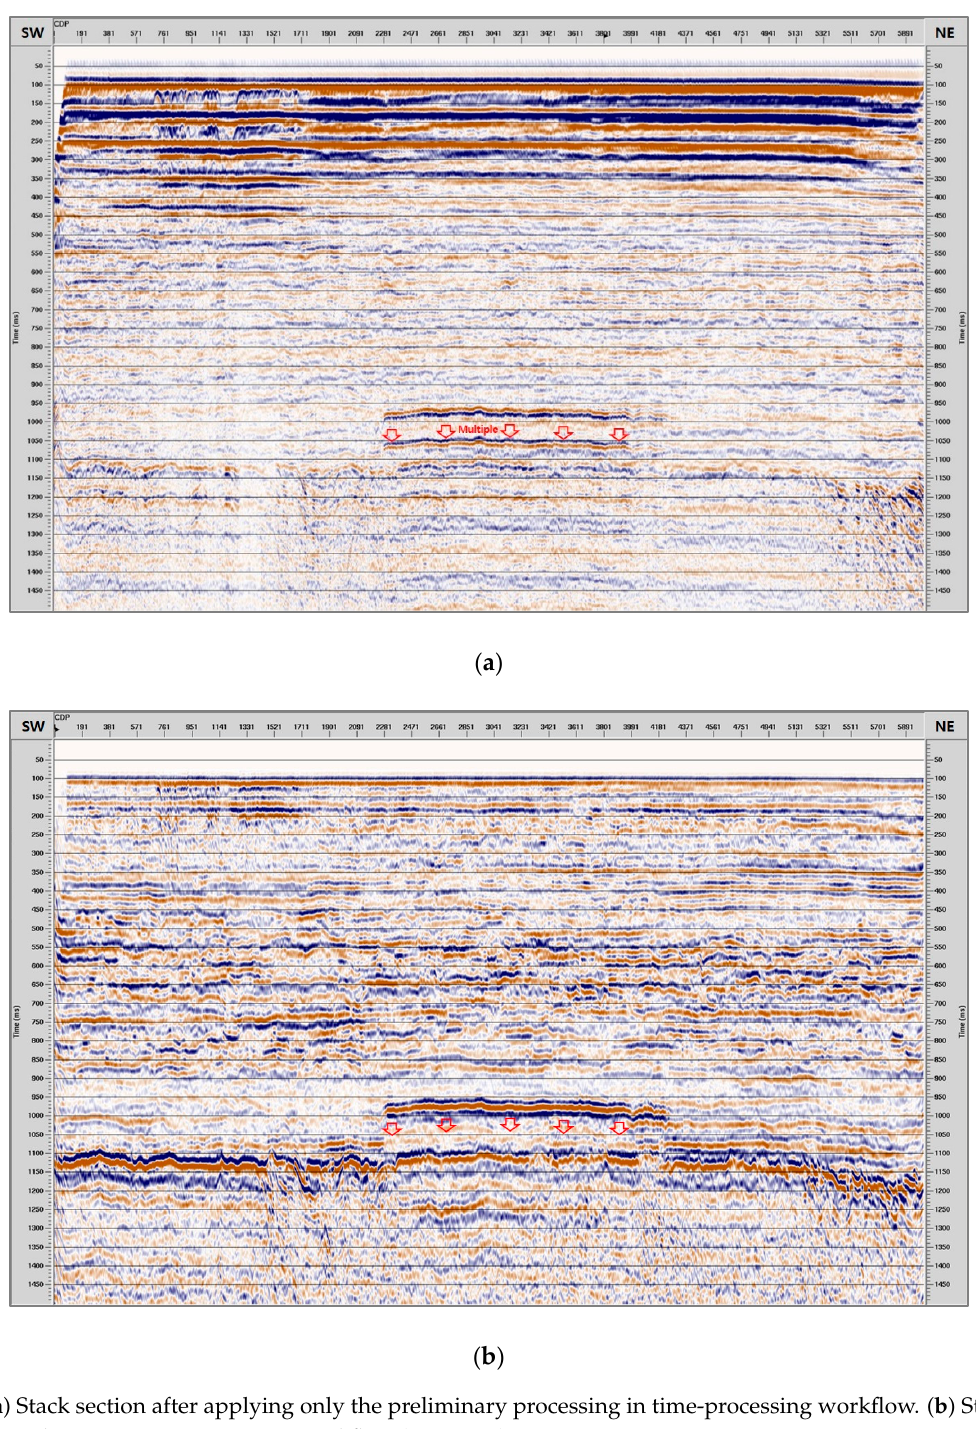
Figure 5. ( a ) Stack section after applying only the preliminary processing in time ‐ processing workflow. ( b ) Stack section after applying the entire time ‐ processing workflow (Figure 3a).